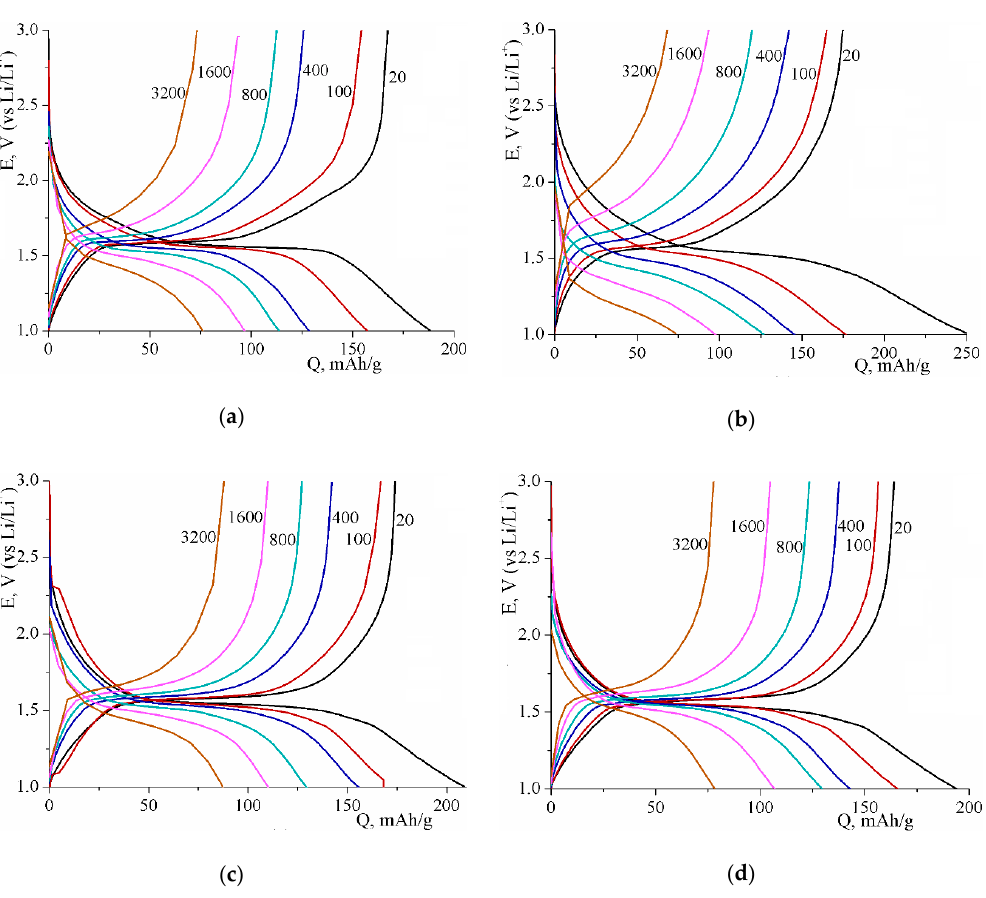
Figure 4. Charge-discharge curves of the LTO ( a ), LTO / 5%G_157M ( b ), LTO / 5%CB ( c ), and LTO / 5%CR ( d ) samples.